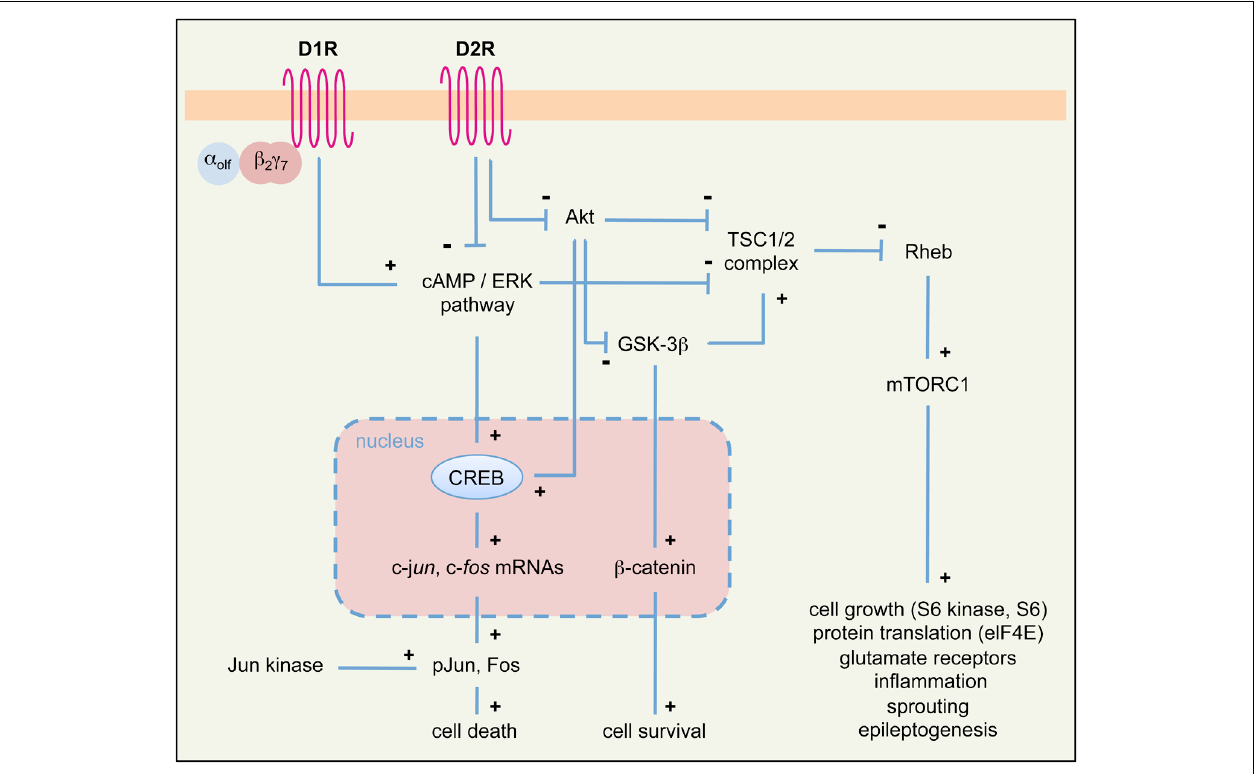
FIGURE 3 | Simplified diagram of intracellular pathways downstream of DA receptors, potentially involved in seizure-induced cell death and epileptogenesis in the limbic system. We propose that signaling cascades downstream of D1R and D2R may converge on two principal intracellular pathways (PKA/ERK/Fos/Jun and Akt/GSK-3 β /mTOR) to regulate